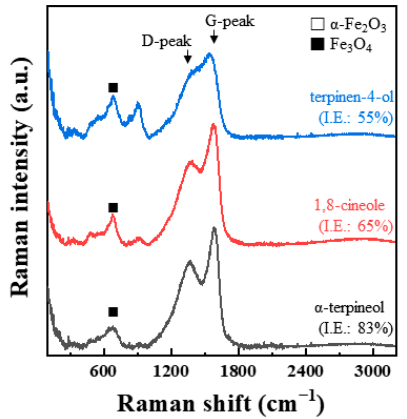
Figure 10. ( a ) Raman spectra analyzed from the surface of STS specimens after immersion for 168 hours in 1 M HCl solution at 298 K with 0.75 g/L of tea tree extract. ( b , c ) OM images showing the surface morphology of corroded STS specimens. Spots of Raman spectroscopic measurement are marked by arrows in OM images.